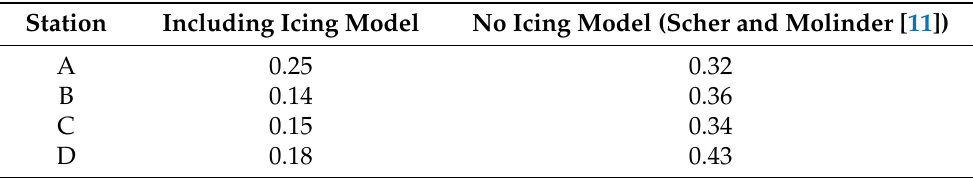
Table 3. The forecast skill in RMSE tested on the same 20% set of the total amount of data, as in Scher and Molinder